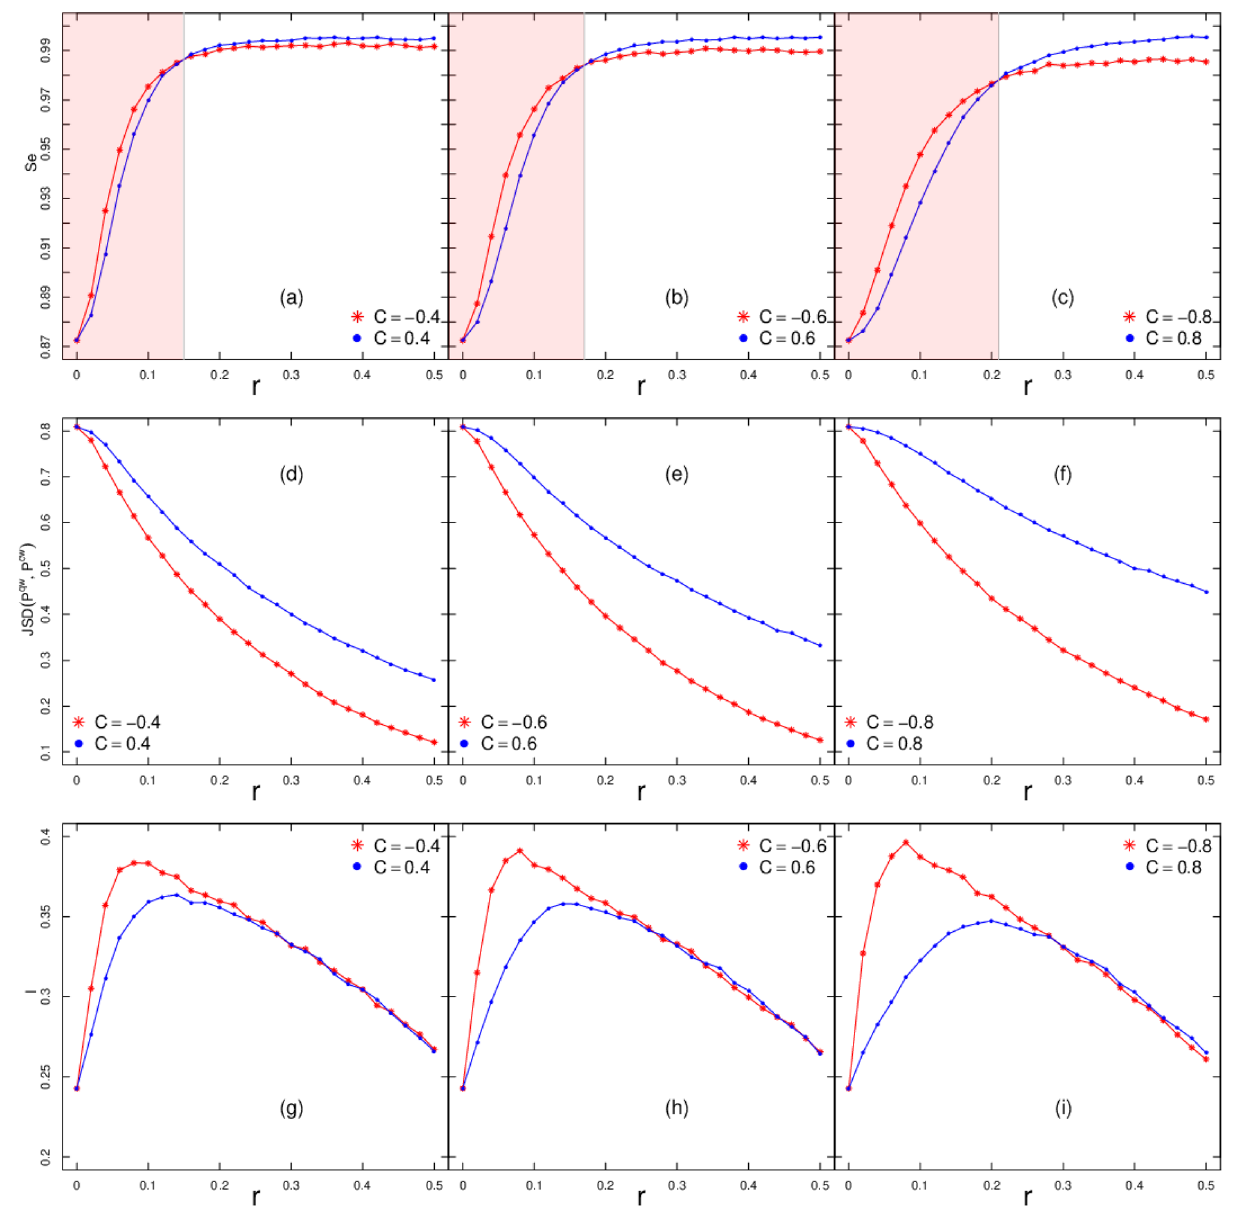
Figure 4. Entanglement entropy S e ( a – c ), Jensen–Shannon dissimilarity JSD ( d – f ), Interference measure I ( g – i ) 500 for increasing disorder strength r and C at t = over 500 samples. The red shadow area for ( a – c ) shows the regime where anticorrelation gives a clear advantage in terms of S e